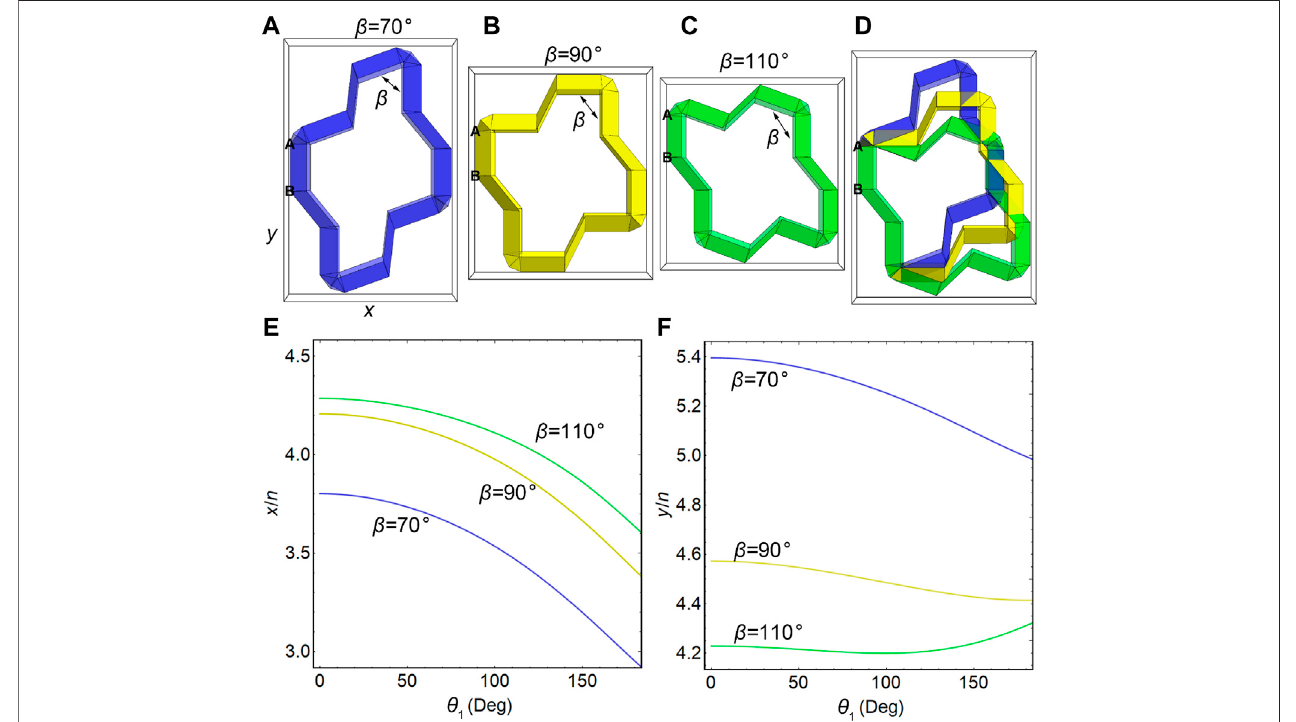
FIGURE 2 | Shearing deformation modes of the ring-like unit. Con fi gurations of the ring-like unit with (A) β (cid:1) 70 ° , (B) 90 ° , and (C) 110 ° . (D) Overlapped con fi gurations of (A – C) . The dimensionless size, (E) x / n and (F) y / n , as functions of the deformation angle θ 1 with (A) β (cid:1) 70 ° , (B) 90 ° , and (C) 110 ° . Here, γ 1 (cid:1) 45 ° and γ 2 (cid:1) 60 °